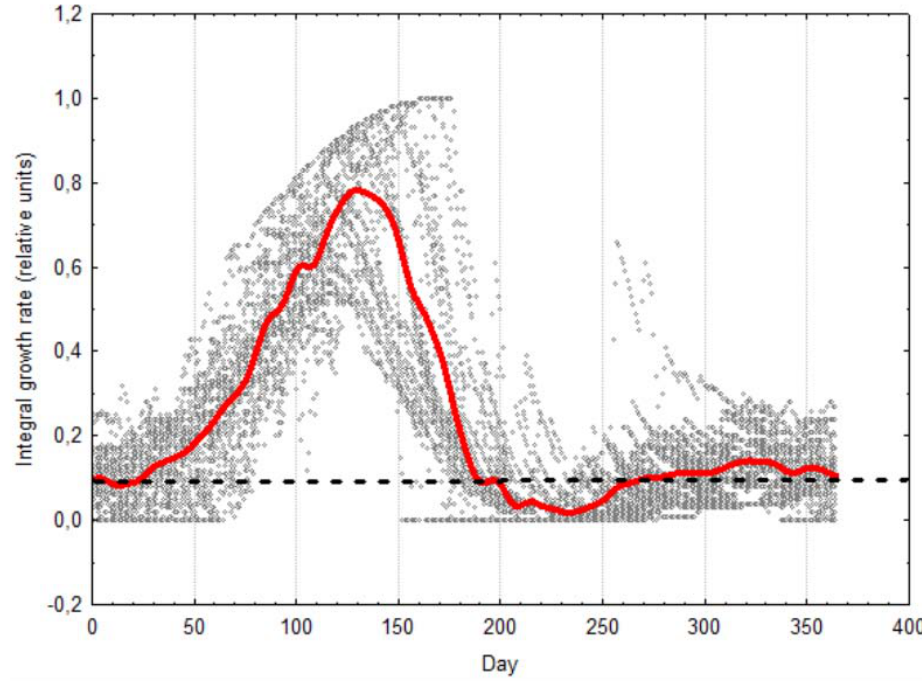
Fig. 4. Average integral growth rate Gr( t) (red line) for calibration period (1982-2004) fitted by negative exponentially-weighted smoothing (Mclain 1974). Dashed line corresponds to minimum cambial cell growth rate V cr .